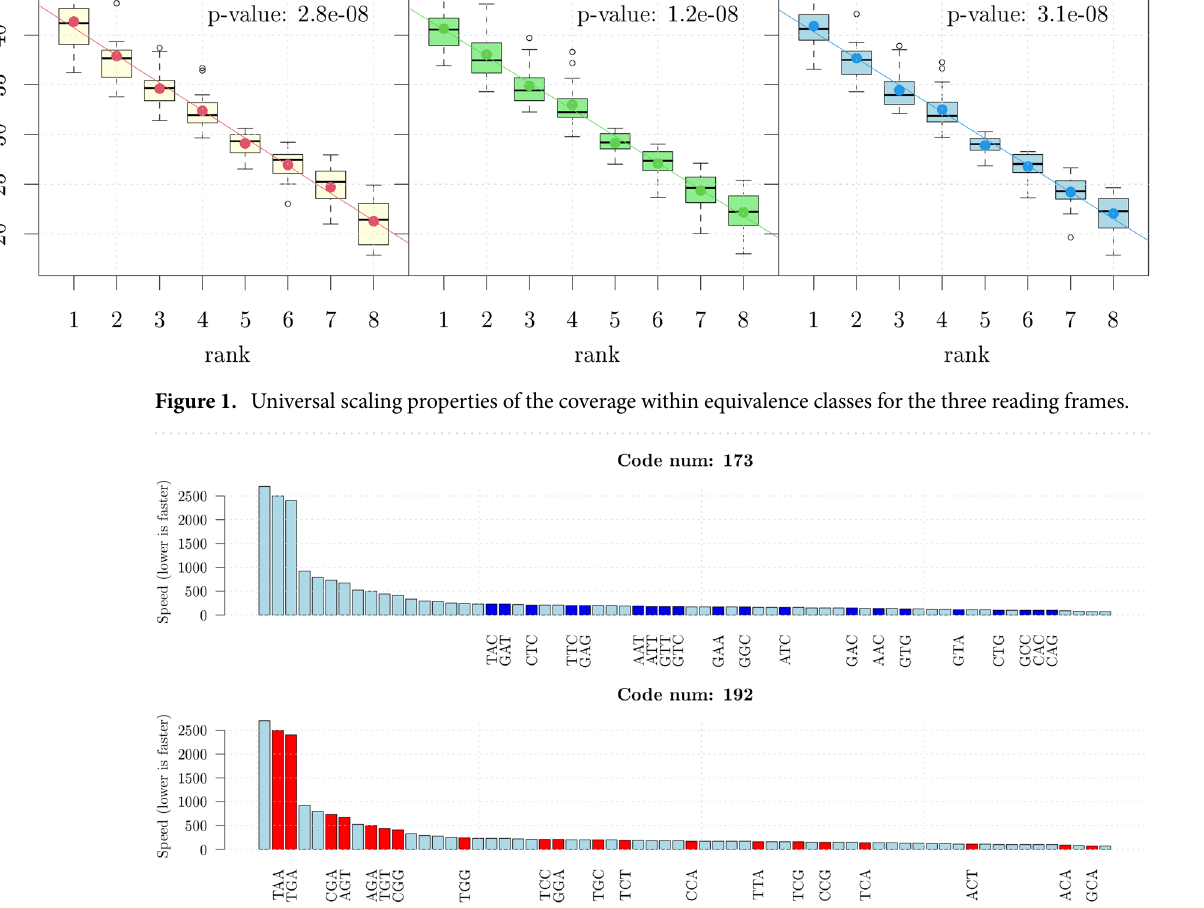
Figure 2. Ordered speed of the 64 codons, the data come from the experiment of 18 and lower values indicate faster codons. The codons coloured in blue (upper panel) and in red (lower panel) belong to code X 173 and X 192 , respectively. They are the best and worst codes within the set of 8 codes forming the equivalence class shown in Table